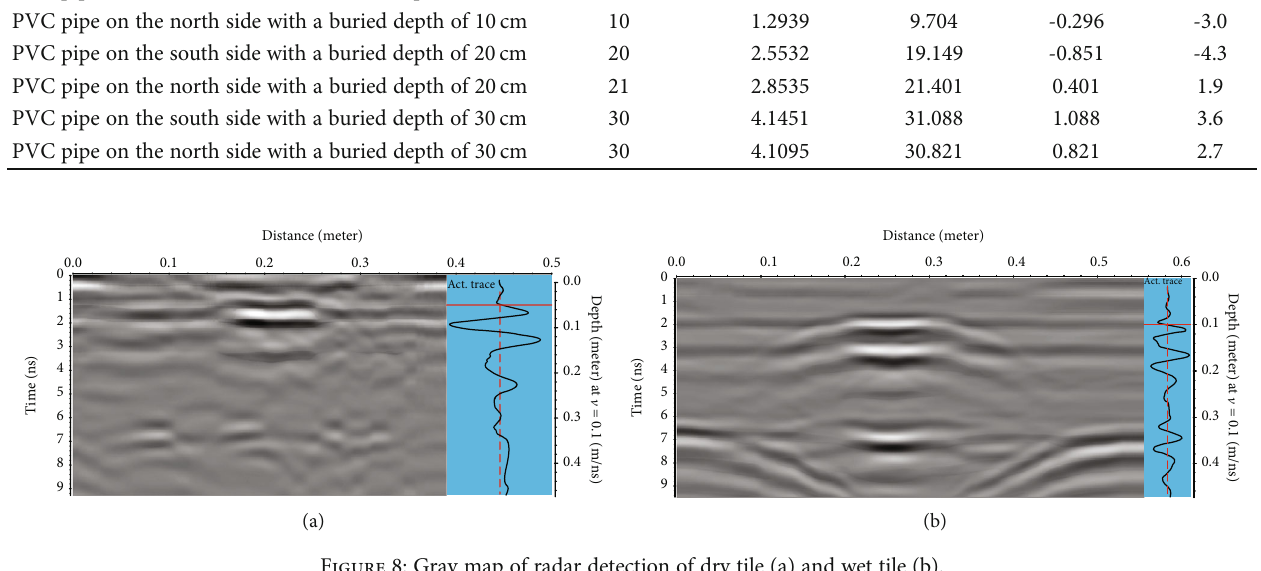
Figure 8: Gray map of radar detection of dry tile (a) and wet tile (b).